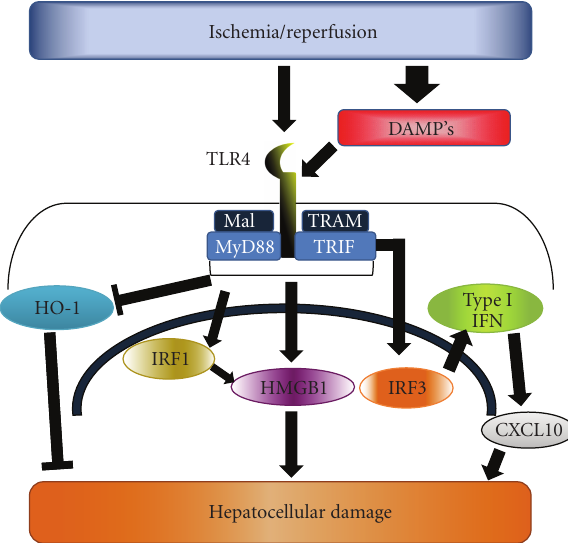
Figure 1: Role of TLR4 in hepatic I/R injury. Signaling through the pattern recognition receptor TLR4 mediates multiple inflammatory pathways following hepatic I/R. The activation of TLR4 signaling is dependent, in part, on circulating DAMPs. Downstream signaling events include the TRIF-dependent activation of IRF3, the pro- duction of Type I IFN, and upregulation of CXCL10. Additionally, TLR4 activation of IRF1 promotes release of the DAMP, HMGB1. Lastly, TLR4 activation is thought to suppress the cytoprotective HO-1